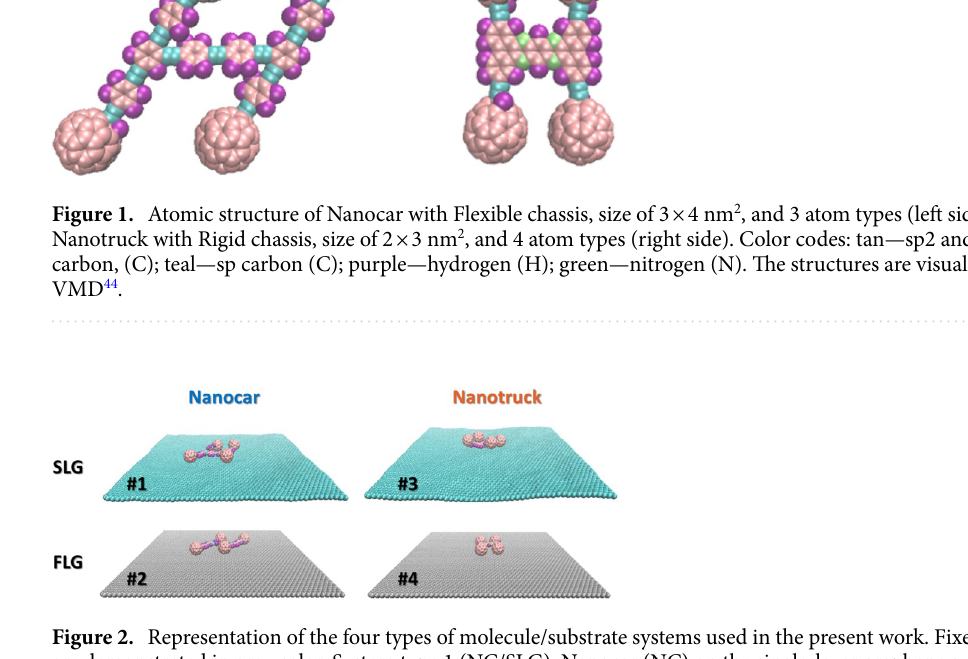
Figure 2. Representation of the four types of molecule/substrate systems used in the present work. Fixed atoms are demonstrated in gray color. System type 1 (NC/SLG), Nanocar (NC) on the single-layer graphene substrate where long-range ripples of graphene can be observed. System type 2 (NC/FLG), all substrate atoms are kept fixed. System type 3 (NT/SLG), Nanotruck (NT) on the single-layer graphene substrate where long-range ripples of graphene can be observed. System type 4 (NT/FLG), all substrate atoms are kept fixed. The structures are visualized by VMD 44